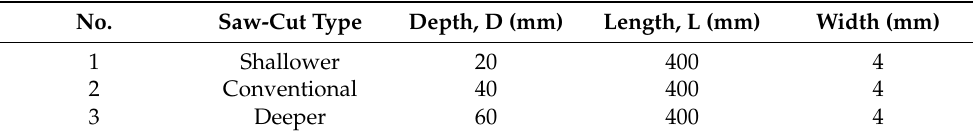
Table 5. Type of saw-cut based on cut-depth.